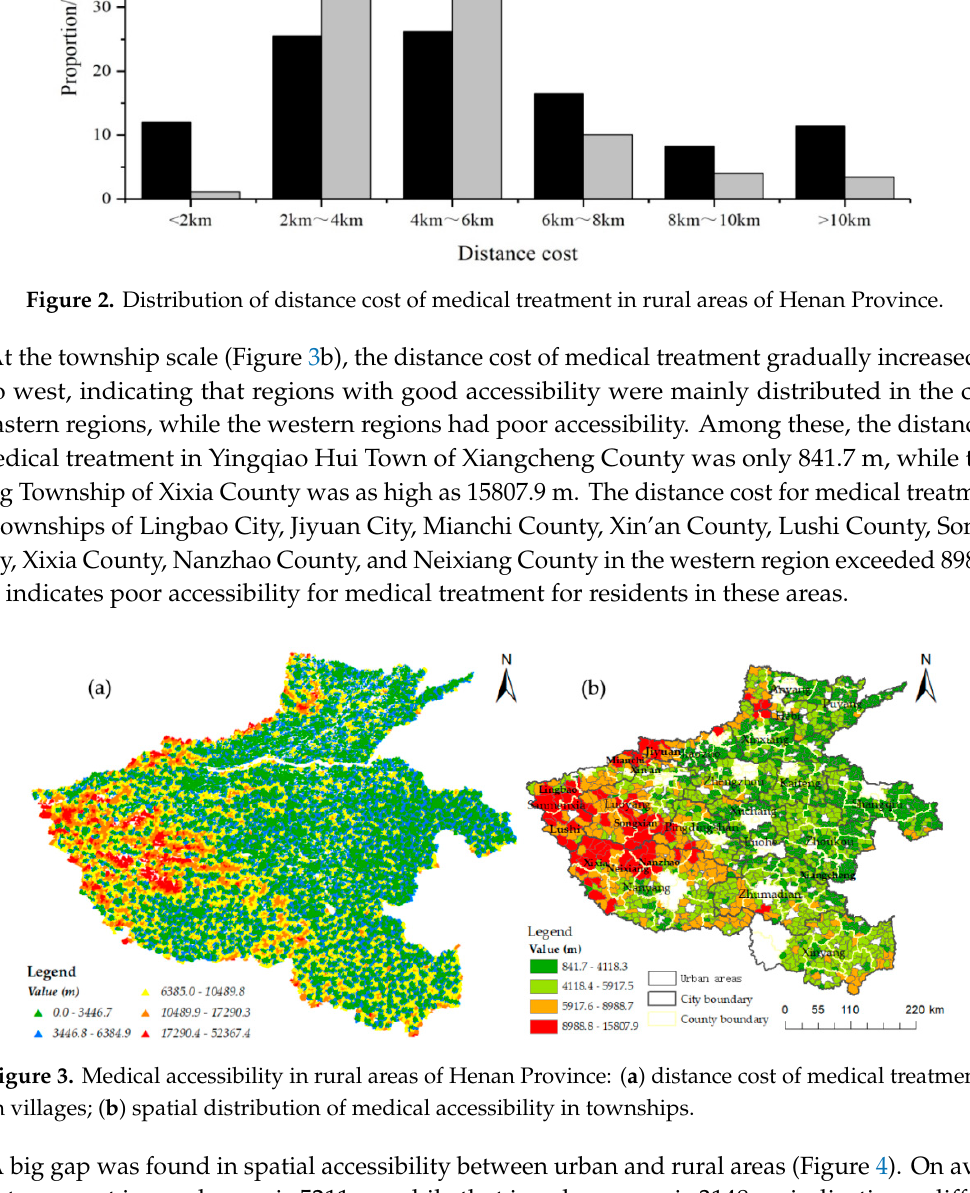
Figure 4. Differences in spatial accessibilities between urban and rural areas.